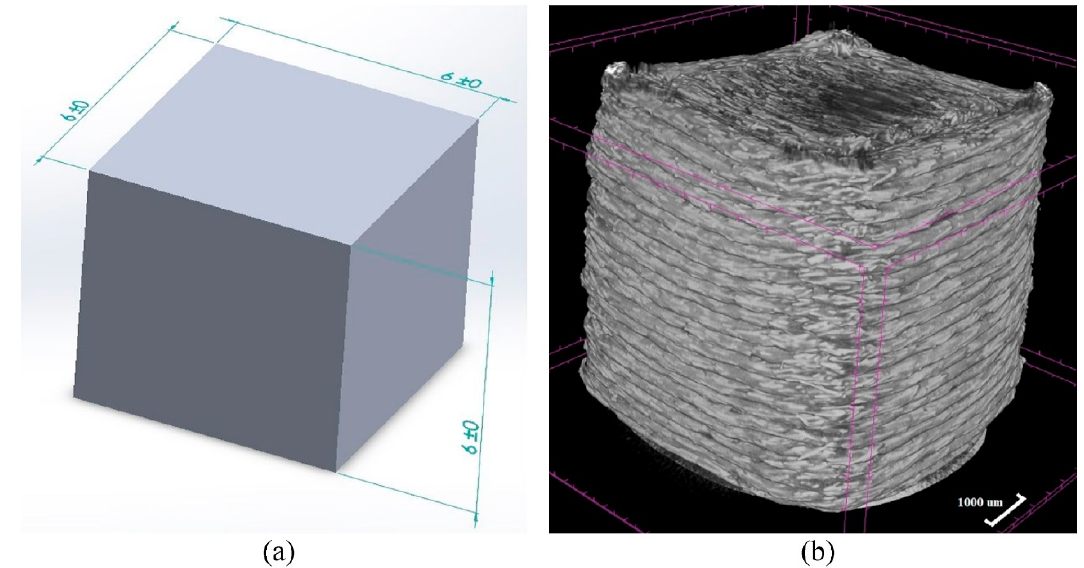
Figure 23. Data prepared to train a machine learning model [88]. (reprinted with kind permission from Elsevier).